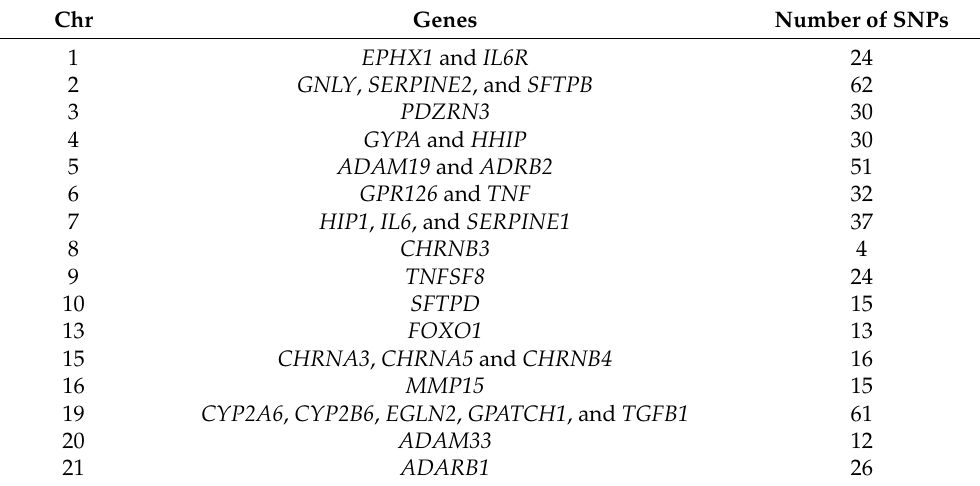
Table 1. Genes included in this study and the number of single nucleotide polymorphisms (SNPs) in each chromosome. Chr